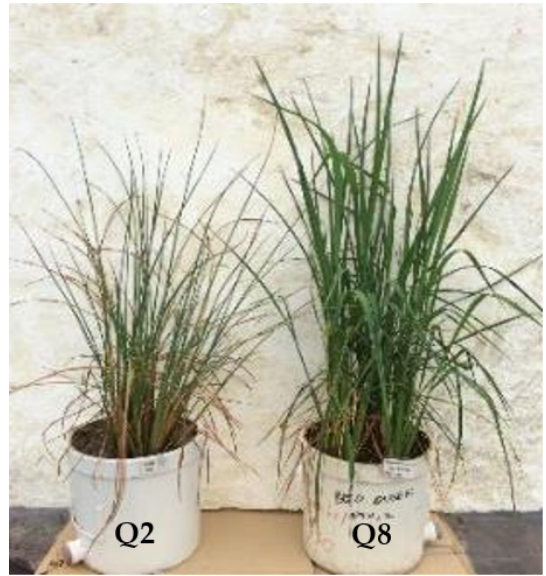
Figure 1. Q2 and Q8 cultivars after 10 days without watering.